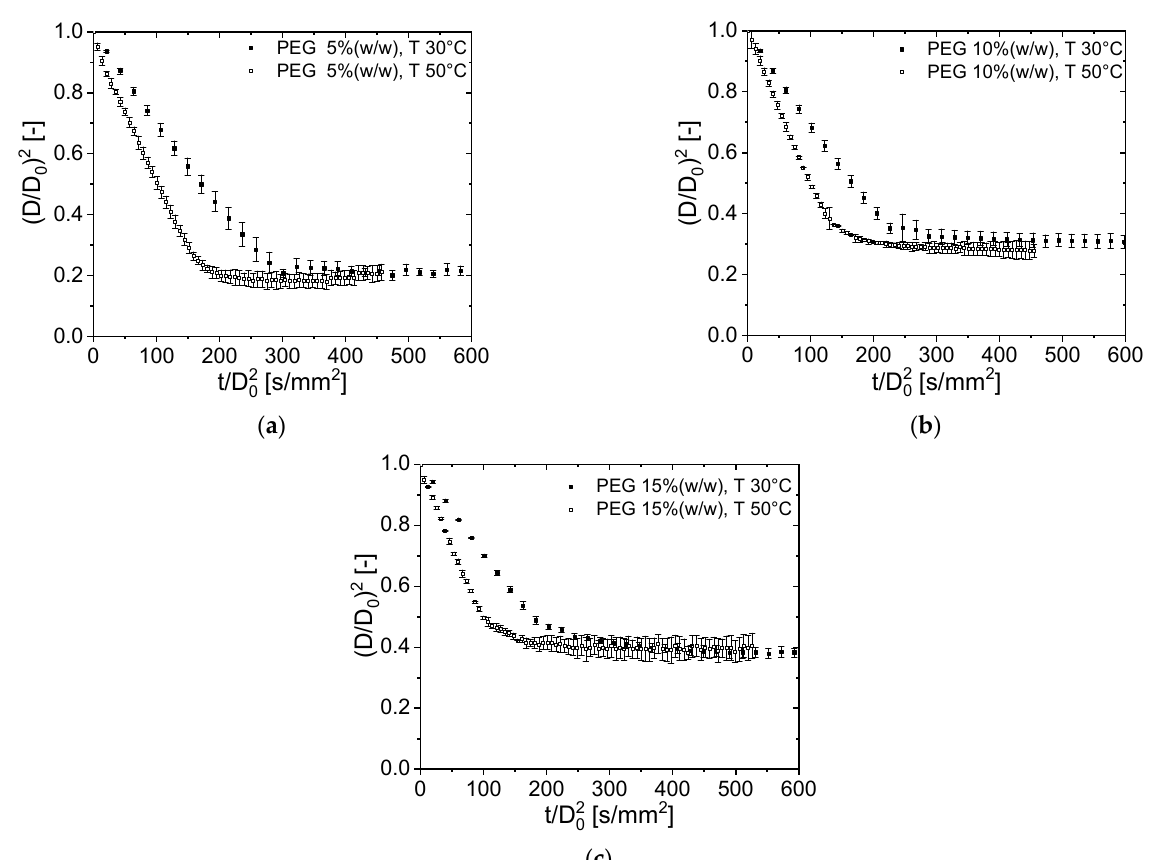
Figure 3. Dimensionless droplet surface evolution, initial PEG600 mass fractions in the levitated droplet were ( a ) 5%, ( b ) 10%, and ( c ) 15% ( w / w ).